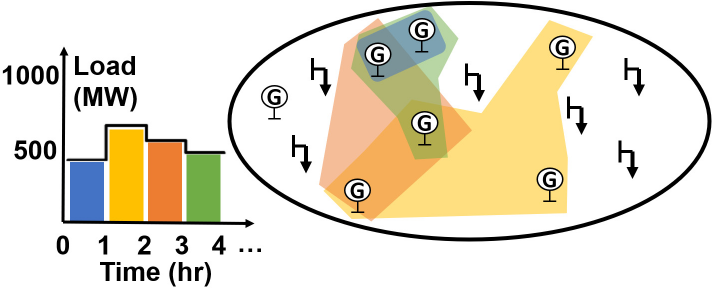
Figure 1. Unit Commitment Problem Illustration (Colored boxes indicate the committed generators in the corresponding-colored time intervals).